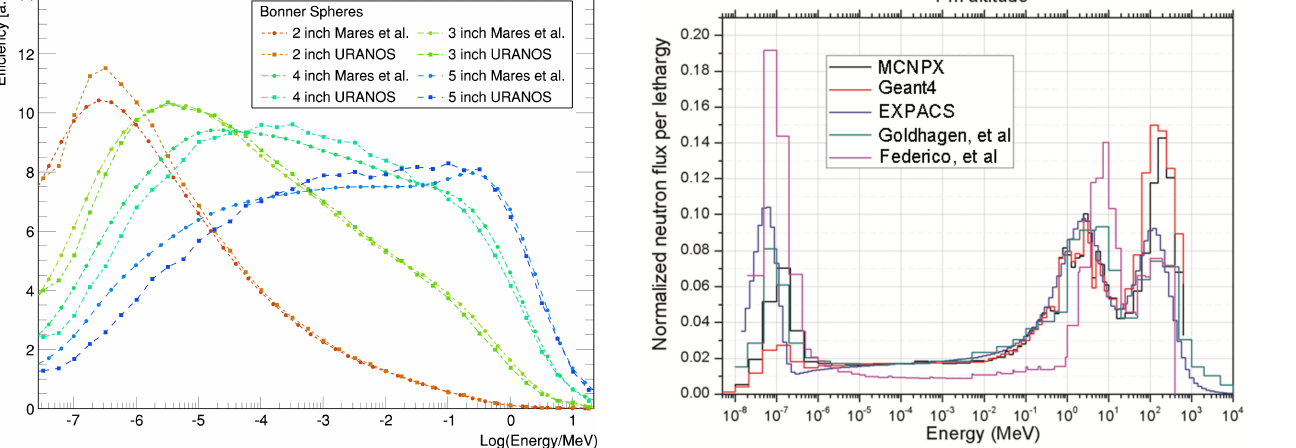
Figure 13. Comparison of simulations of the energy-dependent re- sponse function of Bonner spheres of URANOS and MCNP cal- culations by Mares et al. (1991). The detectors are HDPE (high- density polyethylene) spheres with diameters in the range of (2– 5)in, equipped with a 3.2cm 3 He counter.